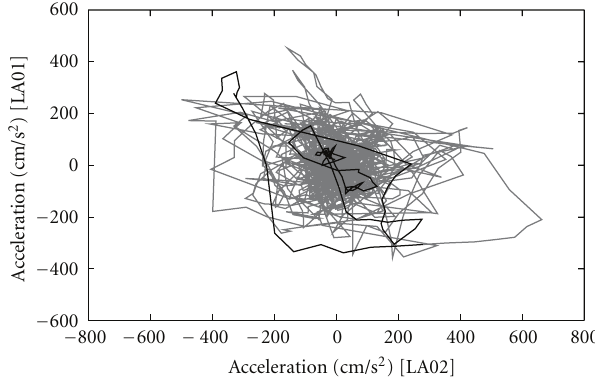
Figure 1: Trajectory of ground acceleration time histories observed during the El Centro Earthquake,